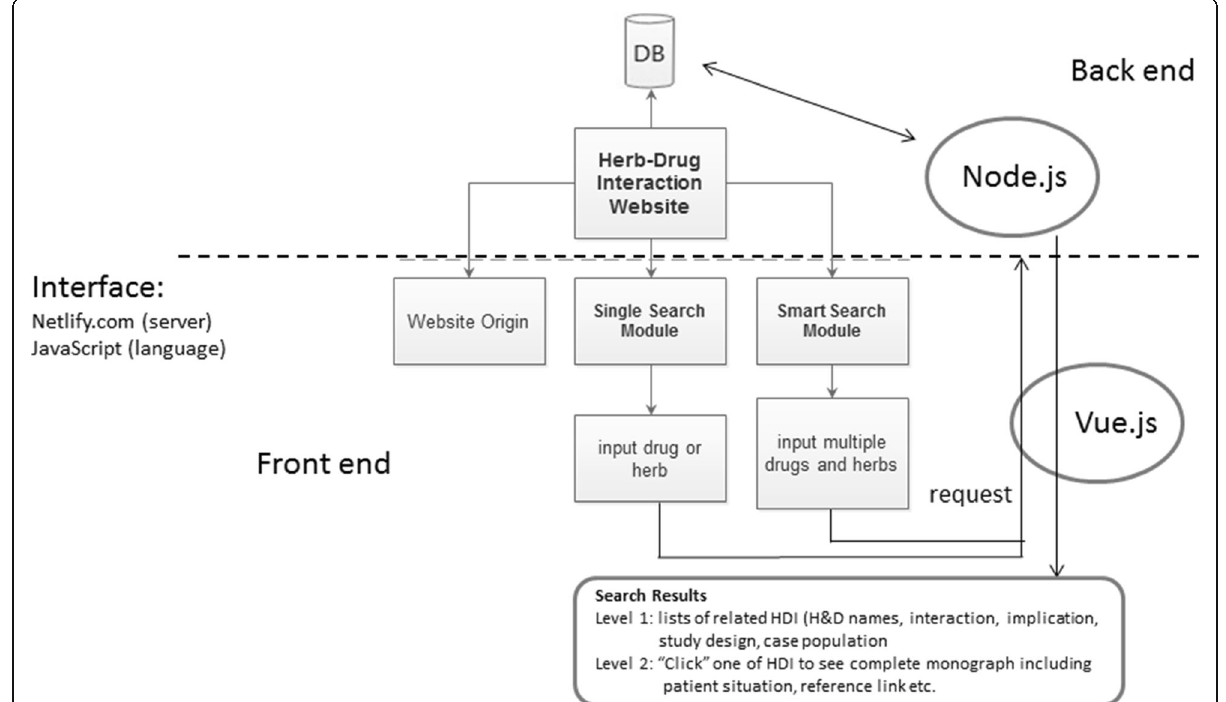
Fig. 1 The functional framework for the current HDI web